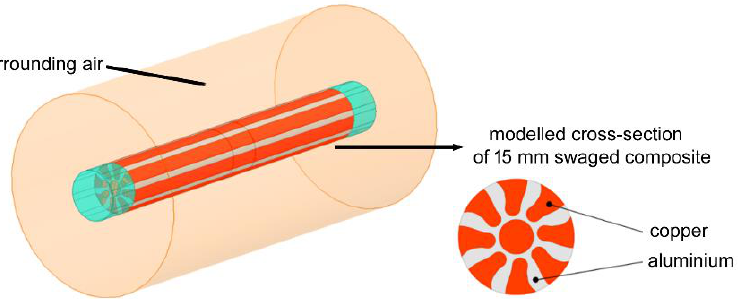
Figure 3. General model of clad composite rods used in numerical simulations, cross-section of 15 mm modelled composite rod shown in detail.